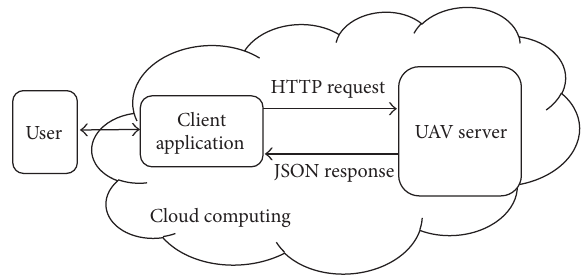
Figure 1: Client-server architecture of integrating UAVs to the